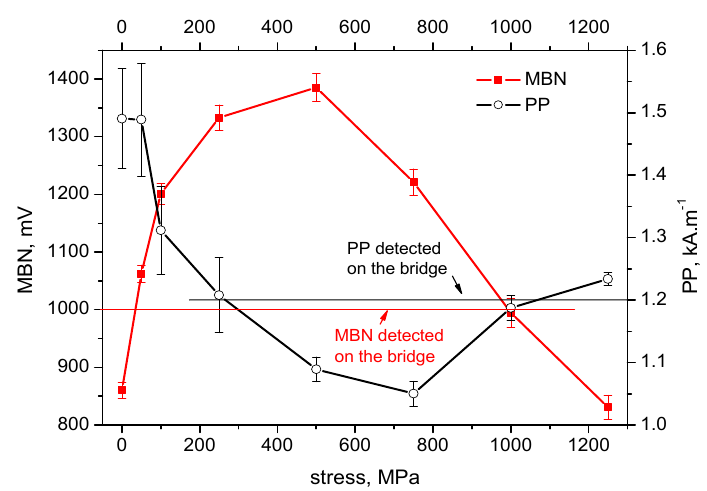
Figure 5. MBN and PP as a function of stress—wire n.2.